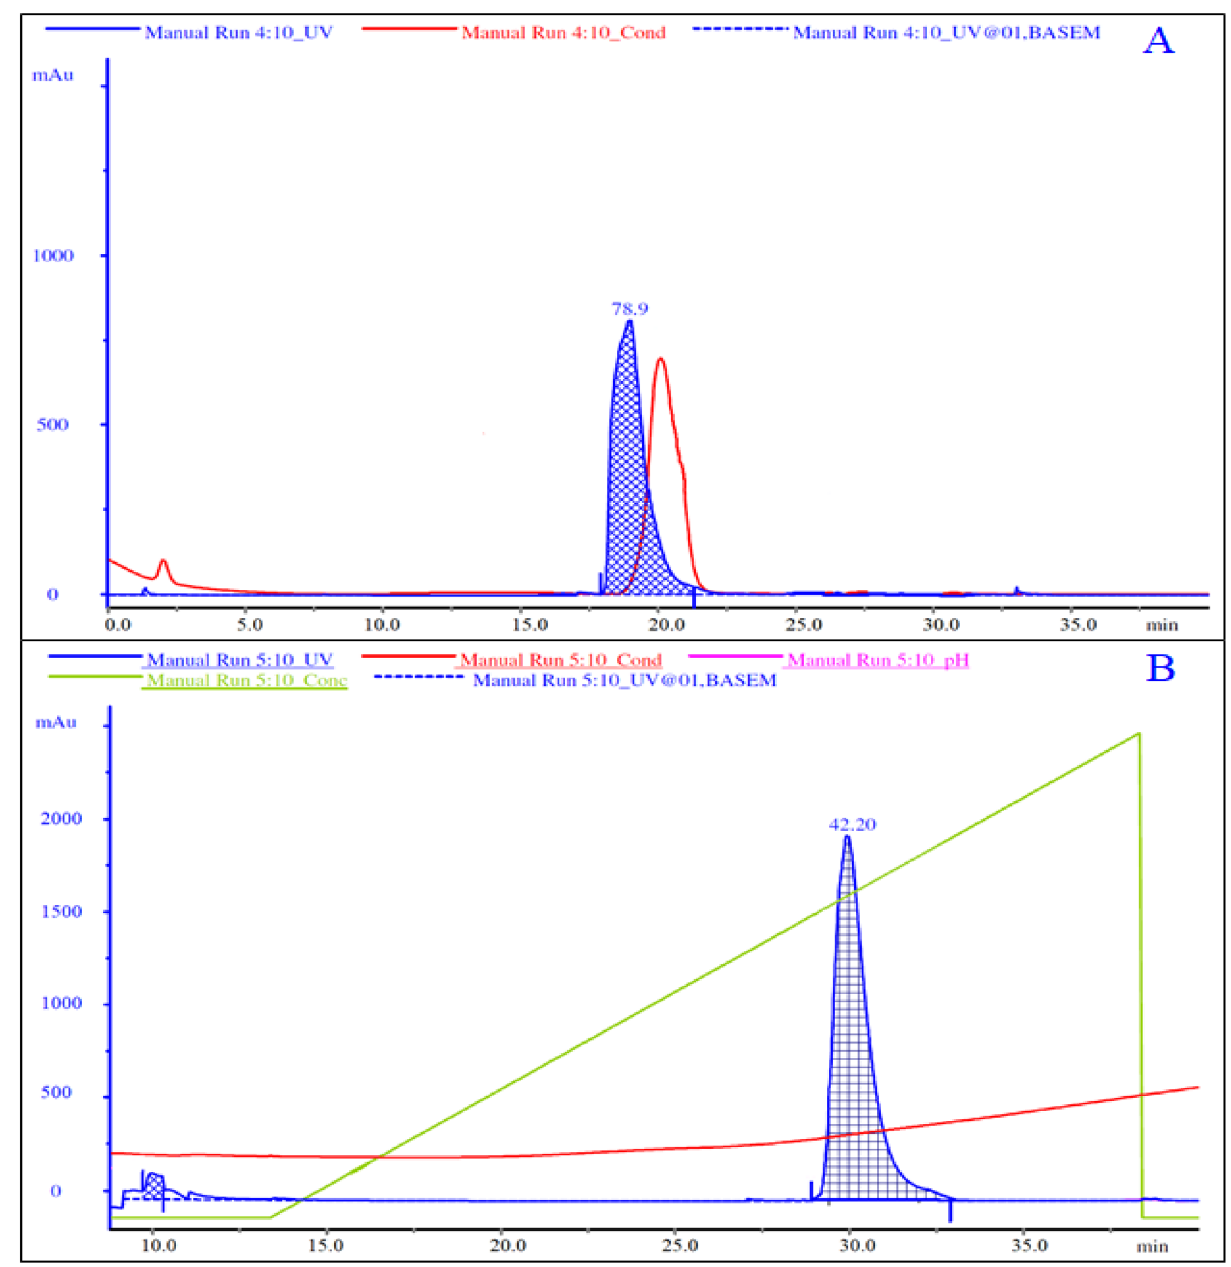
Figure 5. Chromatogram representing purification of naringinase by ( A ) Size exclusion chromatography and ( B ) anion exchange chromatography denoting the equilibration and elution profiles with their respective buffers. The blue line indicates response from the UV detector and the red line indicates conductivity